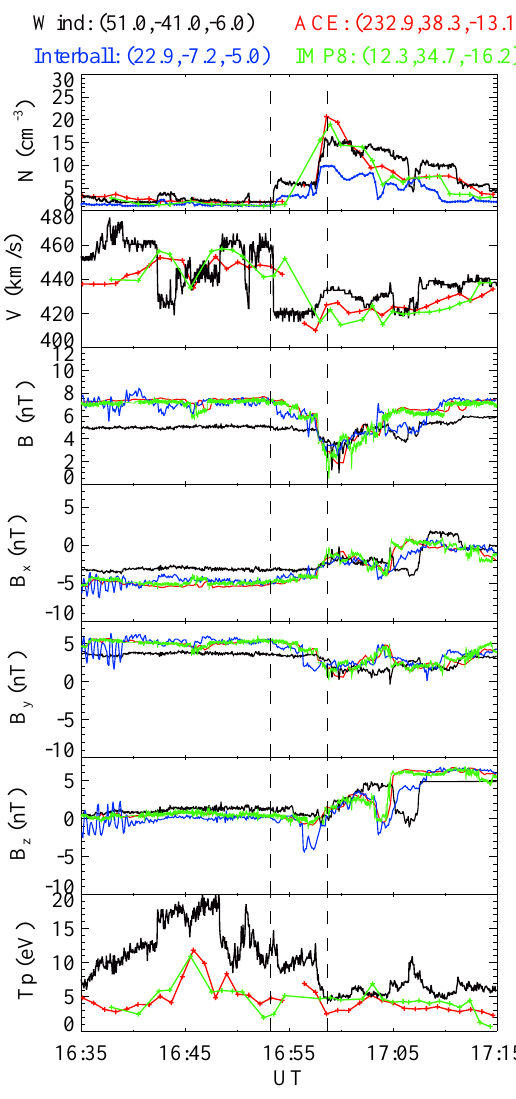
Fig. 3. Solar wind conditions in the GSE coordinate system for the 6 June 2000 event. The parameters are shown in a similar format as in Fig. 1. ACE, Interball-1 and IMP 8 measurements were shifted by 67, 0.83, and 9min,